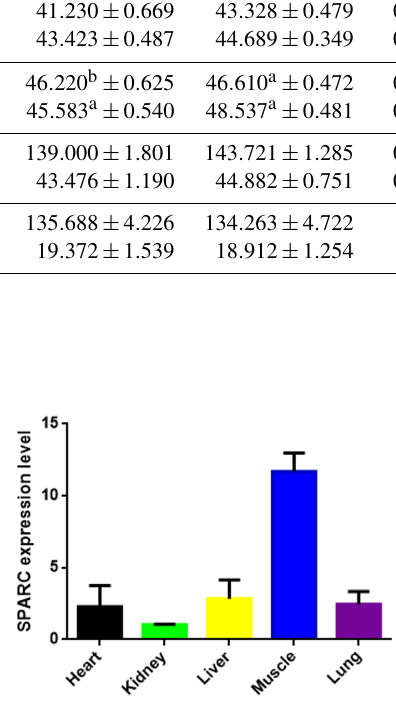
Figure 3. The SPARC mRNA expression level in adult different tissues (relative to the kidney). Note the expression profiling of SPARC gene in different tissues in XN cattle. The values are the averages of three independent experiments measured by 2 − (cid:49)(cid:49) Ct . Error bars represent the standard deviation (SD) ( n = 3), and the relative mRNA expression levels of SPARC gene are normalized; β -actin was used as an internal reference.